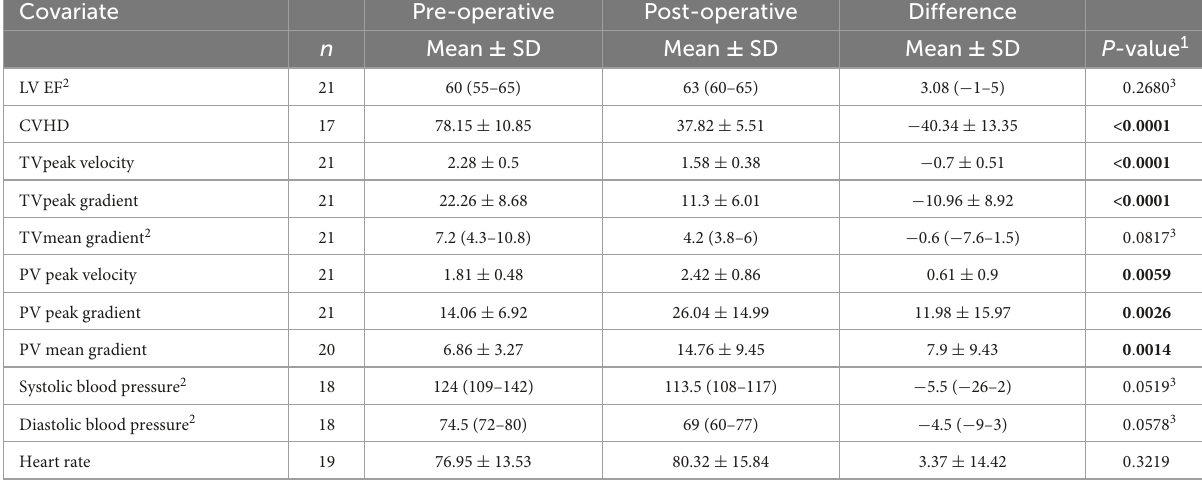
TABLE 3 Comparison of cardiac measurements before and after surgery.